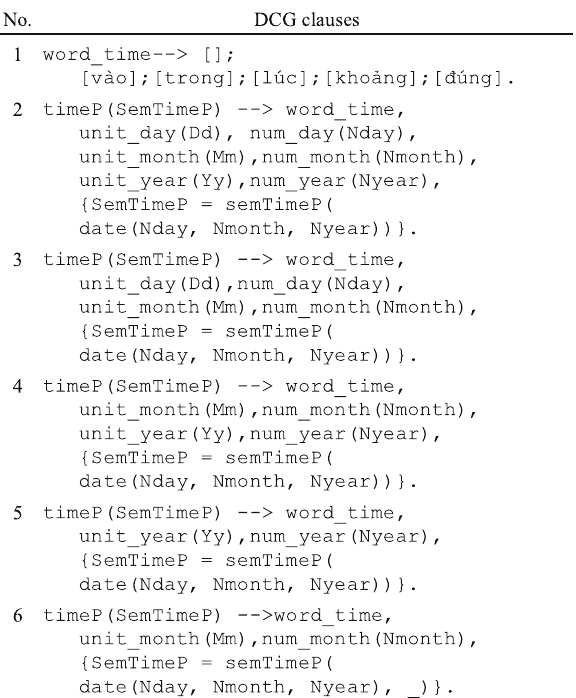
Table10 DCGclausesareusedforcomputingandinferringtheseman- tics of time phrase with date form in